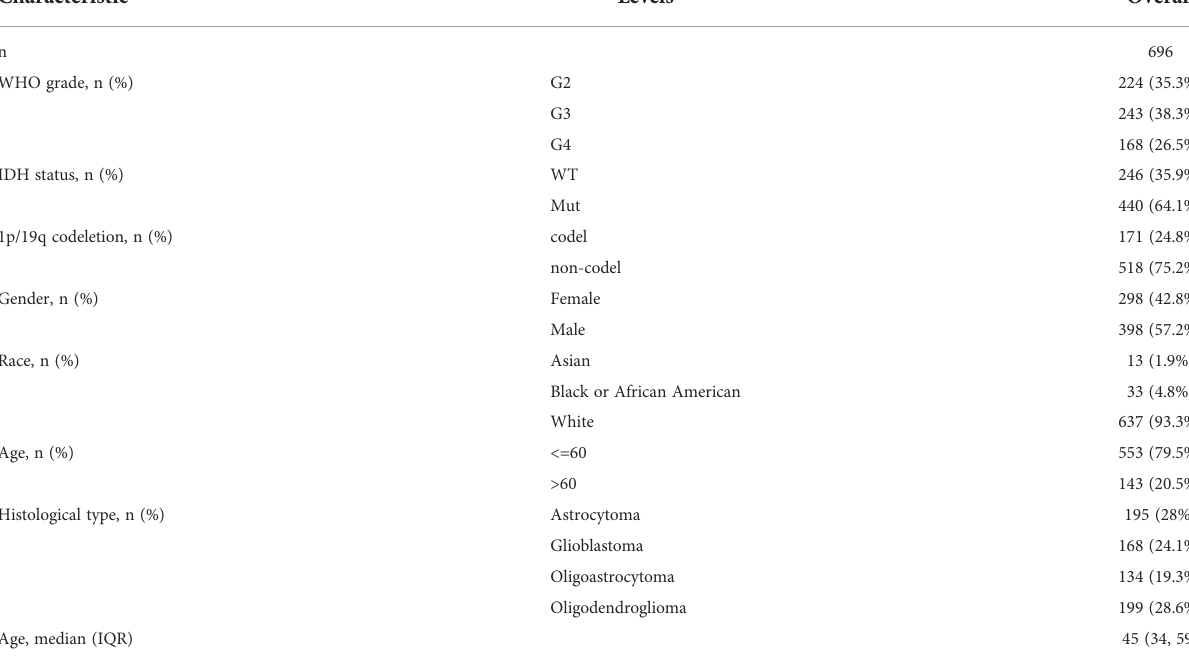
TABLE 1 Baseline data of TCGA